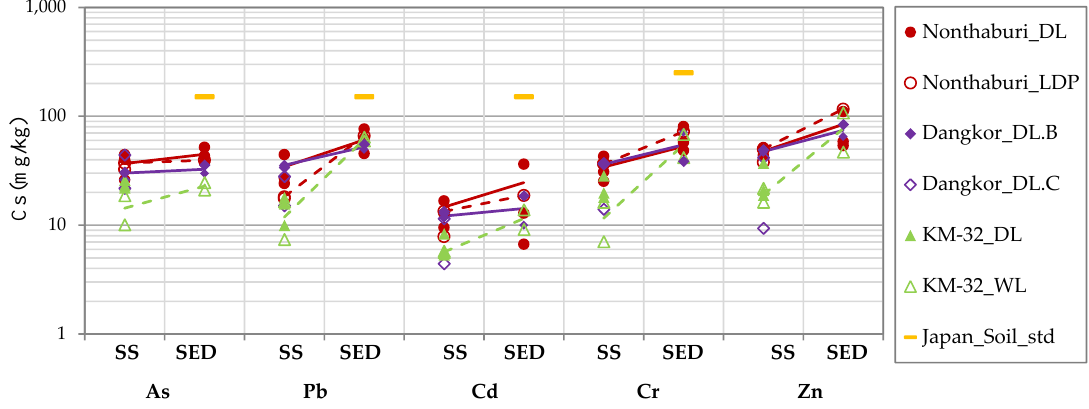
Figure 15. The heavy metal contents of the suspended solids of the leachate (SS) and sediment (SED). All the observed HM contents of the sediment were lower than the limit specified by the Soil